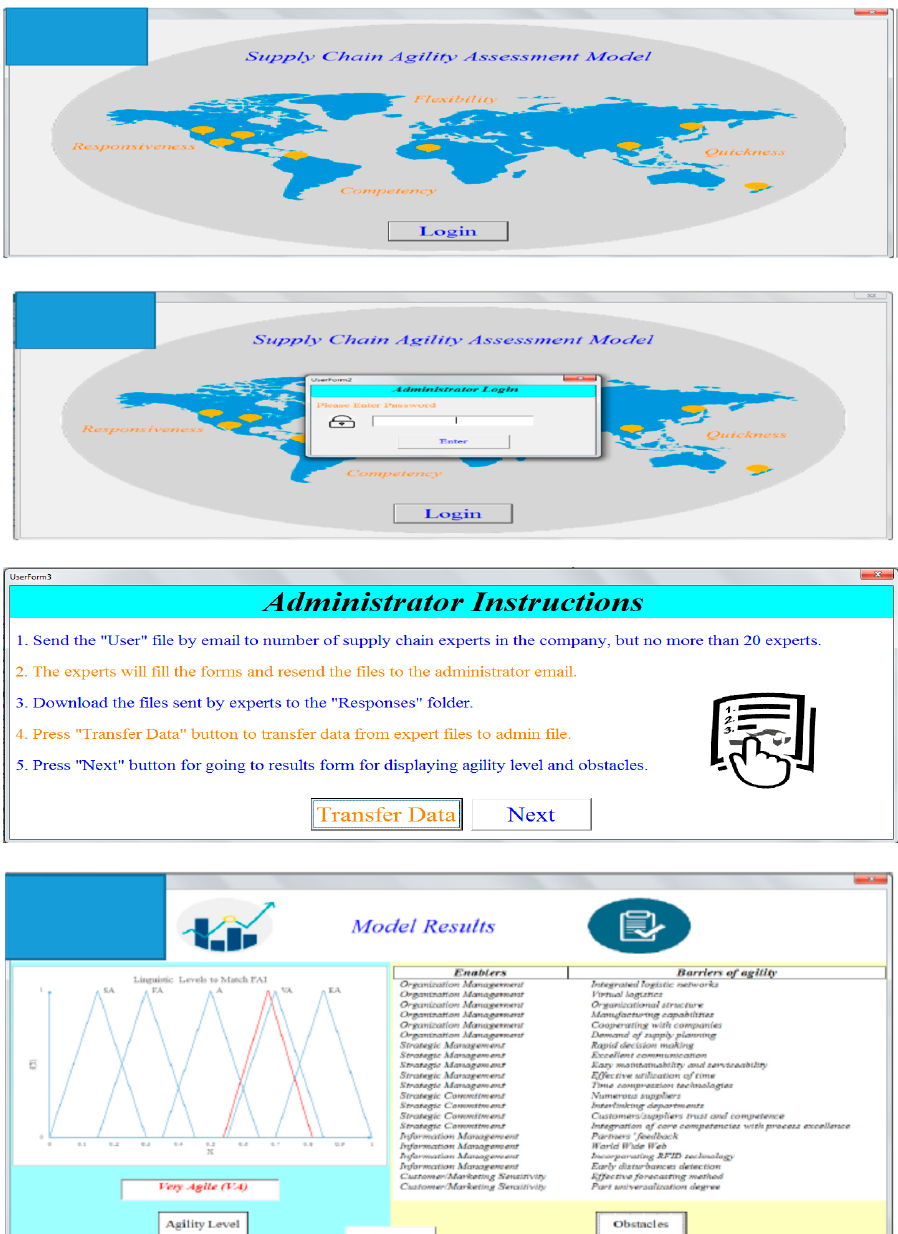
Figure 3. Screenshots of the “Assessment” Interface.